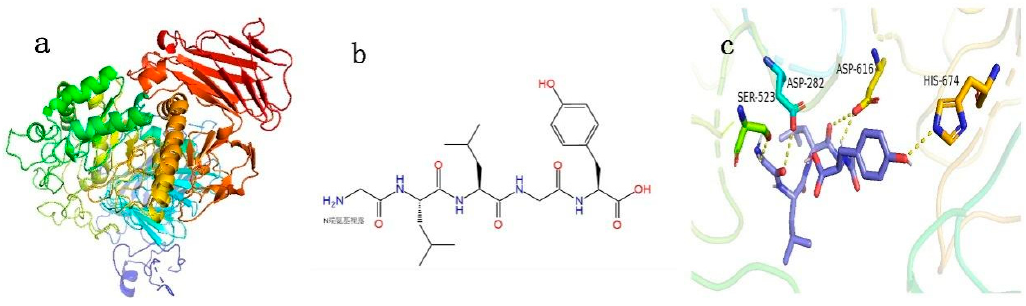
Figure 4. The binding interactions between oligopeptide GLLGY and human α -glucosidase. ( a ) Three-dimensional structure of α -glucosidase. ( b ) The structure of oligopeptide GLLGY. ( c ) Interaction diagram of GLLGY with α -glucosidase. The yellow dotted lines indicate hydrogen bonds.